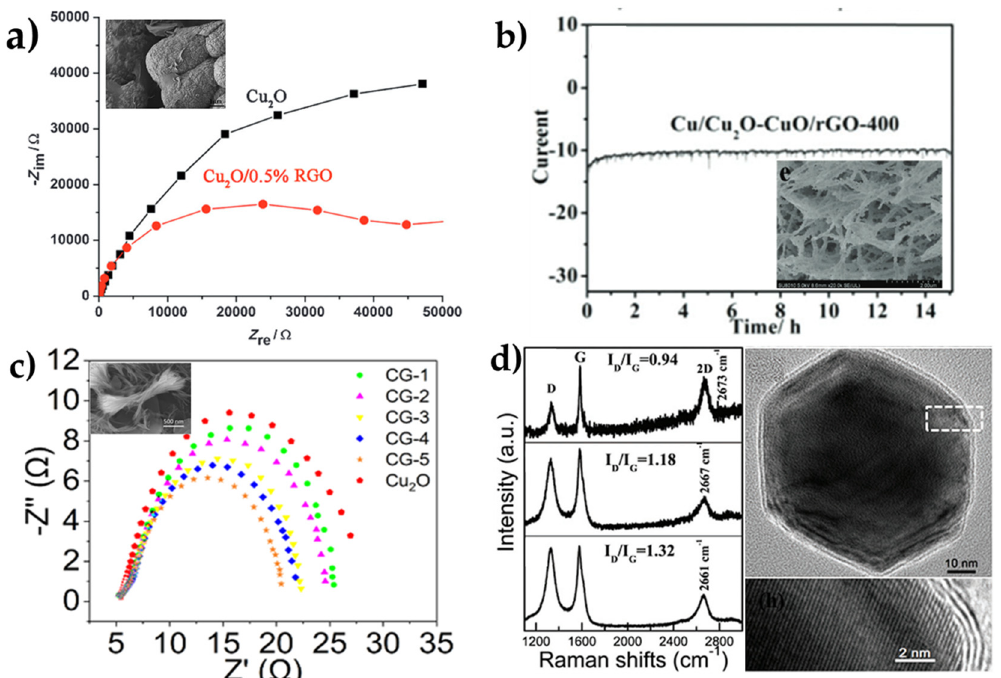
Figure 5. ( a ) EIS of composite electrodes to exploit the charge transfer resistance of pristine Cu 2 O and Cu 2 O/reduced graphene oxide and subplot of SEM image of Cu 2 O/RGO composites. Repro- duced with permission from ref. [32]. Copyright 2014 Wiley − VCH. ( b ) Long − term durability of Cu/Cu 2 O − CuO/rGO − 400 and subplot is a SEM image of the same sample. Reproduced from Ref. [44] with permission from the Royal Society of Chemistry. ( c ) Electrochemical impedance spec- troscopy of CG catalysts and Cu 2 O in 1 M KOH with subplot of a SEM image of CG5 after 8 h reaction. Reprinted from [45], with permission from Elsevier. ( d ) Raman spectra for alloyed Ni − Cu encapsuled in graphitic shells with different thickness with thickness to be increasing downwards and TEM images of the NiCu@C − 1 sample. Reproduced with permission from ref. [33]. Copyright 2017 Wiley − VCH.